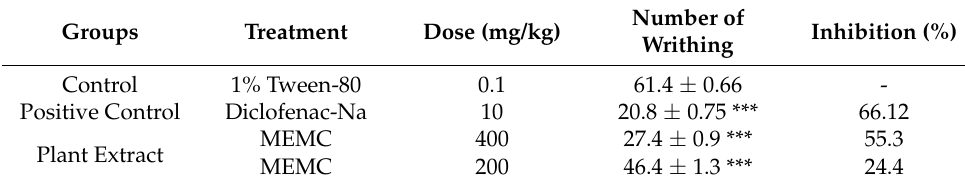
Table 3. Analgesic effect of MEMC in acetic acid induced writhing test in mice. Groups